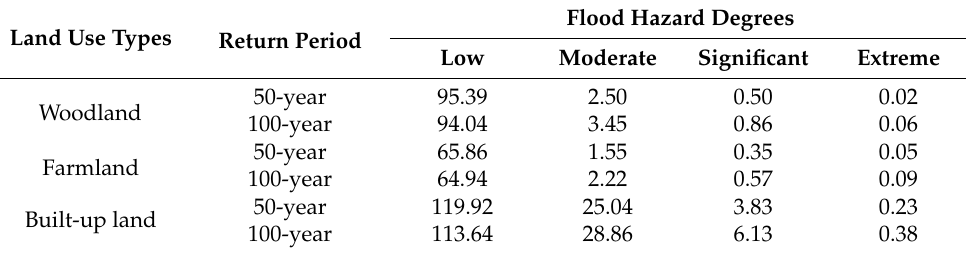
Table 4. Area statistics of different flood hazard areas in different land use types for 50- and 100-year return period unit: km 2 .